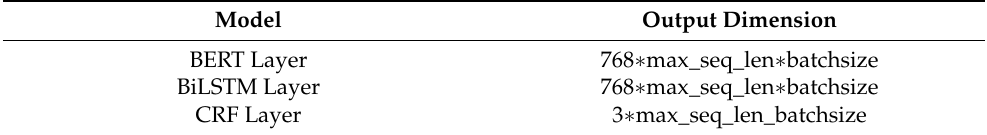
Table 4. BERT-BiLSTM-CRF network structure.